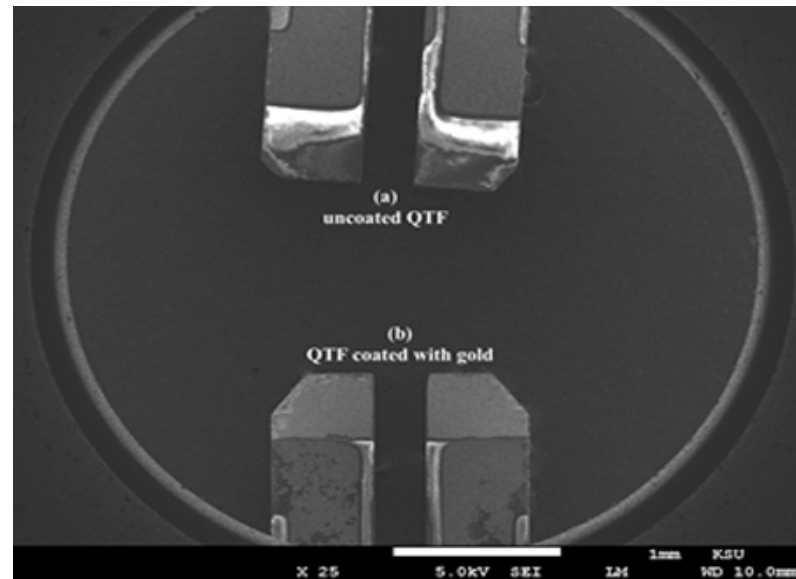
Figure 5. SEM images of ( a ) QTF and ( b ) QTF g .